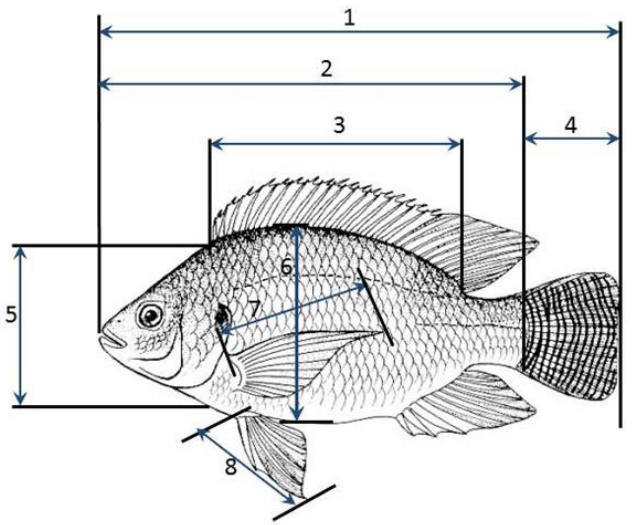
Figure 2. Morphometric measurements of O. niloticus : 1. Total length, 2. Standard Length, 3. Dorsal fin length, 4. Caudal fin length, 5. Head length, 6. Body width, 7. Pectoral fin length, 8. Pelvic fin length (Source: Author photo).